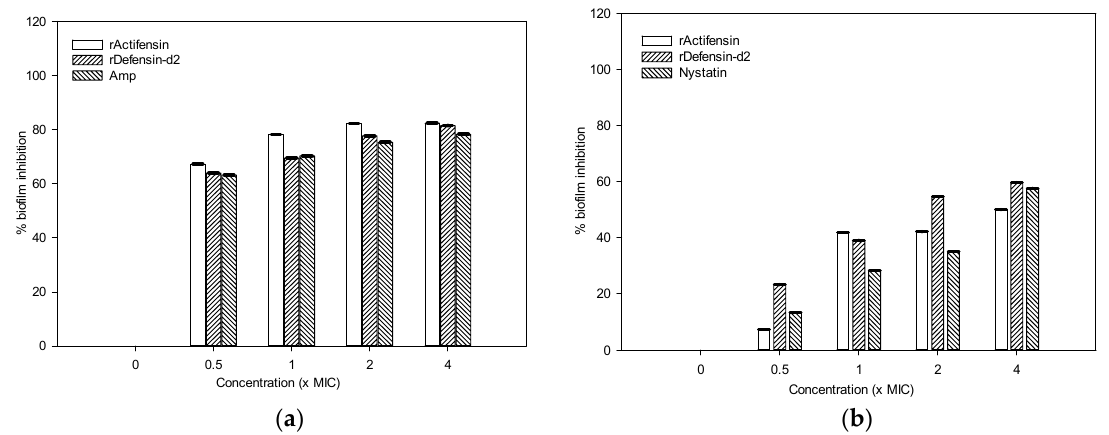
Figure 9. Inhibitory activity of the recombinant peptides on biofilm formation by ( a ) Pseudomonas aeruginosa and ( b ) Candida albicans . Graphs show means and standard error means (as error bars) of triplicate data per concentration.